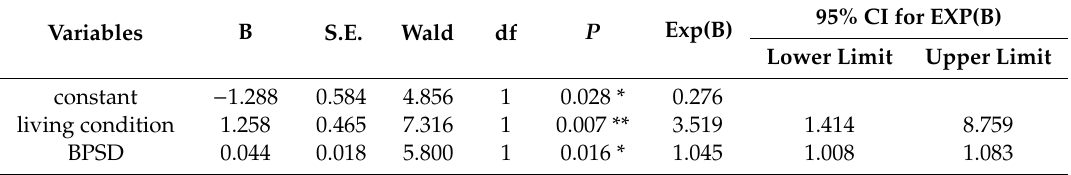
Table 6. Logistic regression model of long-term care service utilization by dementia